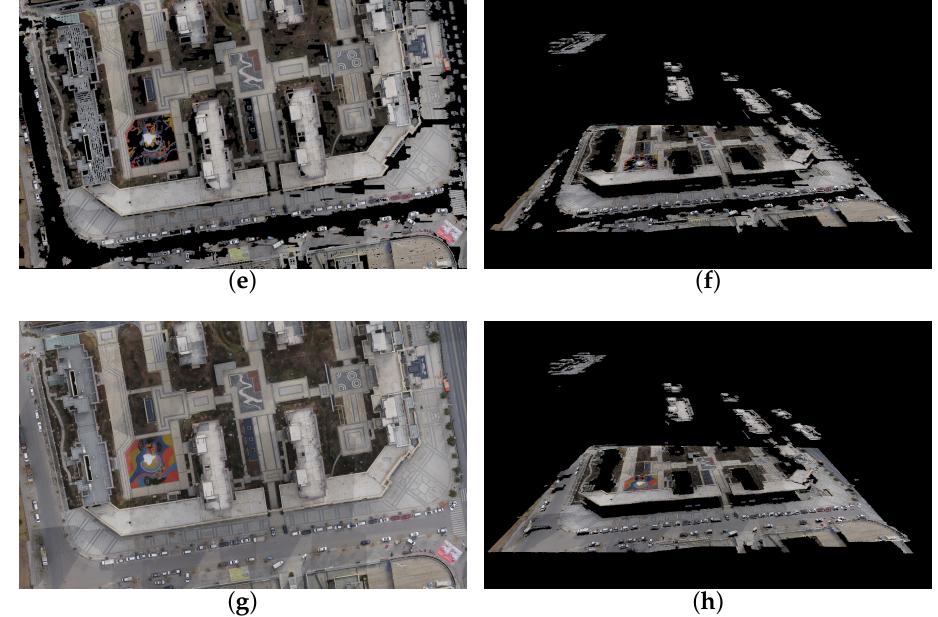
Figure 8. The beginning, two intermediate, and final results of the generation process. The left column ( a , c , e , g ) is the top view, and the right ( b , d , f , h ) is the corresponding oblique view. Figure 9 shows some images used to generate the digital orthophoto of farmland with a factory inside. We use this example to test that the scene has some large areas with less color variation. The generation steps are demonstrated in Figure 10.